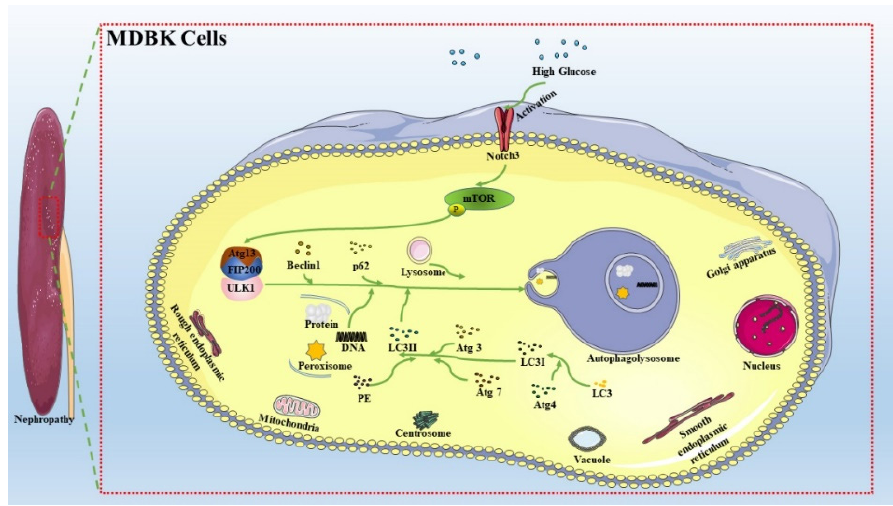
Figure 9. Schematic diagram for the proposed autophagy signaling pathways in MDBK cells regulated by HG. This study provides some theoretical basis for the pathogenesis and treatment of nephropathy induced by hyperglycemia, such as diabetic nephropathy and stress hyperglycemia. Supplementary Materials: The following are available online at https://www.mdpi.com/article/10.3390/molecules27103121/s1, Figure S1: The effect of HG on autophagic flux. MDBK cells were pretreated with CQ (10 µ M) for 6h, and then stimulated with 25.5 mM glucose for another 24 h, and the protein expression level of LC3 was detected by the Western bolt. ** p < 0.01 compared with control